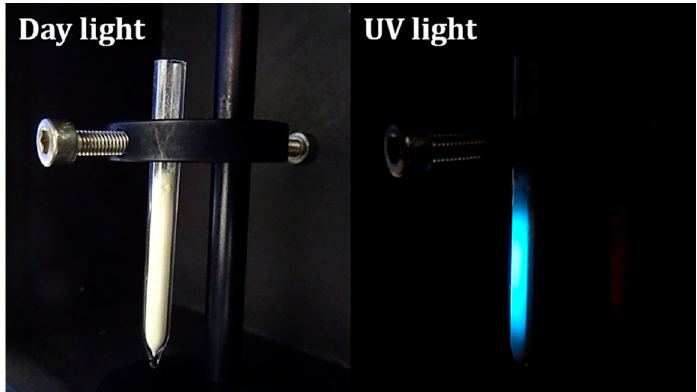
Figure 2. Suprasil quartz ampoule containing Al(acac) 3 crystallized with 25% NH 3 under irradiation of day (left-hand side) and UV (320 nm, right-hand side) light.